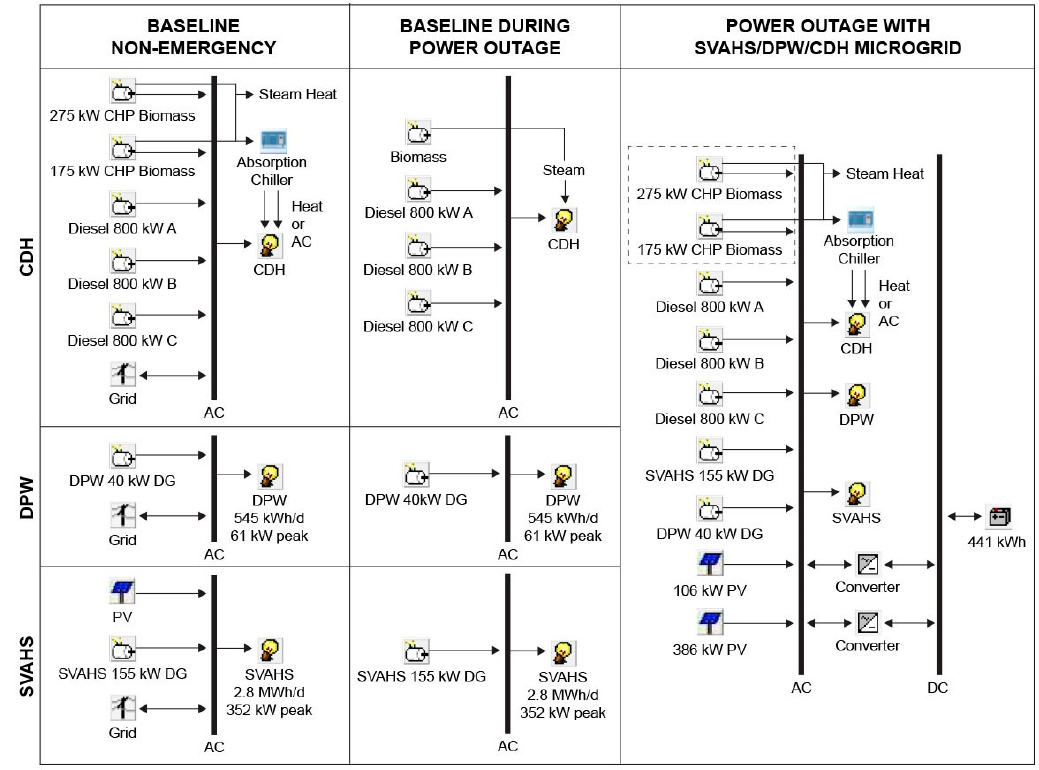
Figure 2. Existing and planned power components of the Northampton microgrid project.